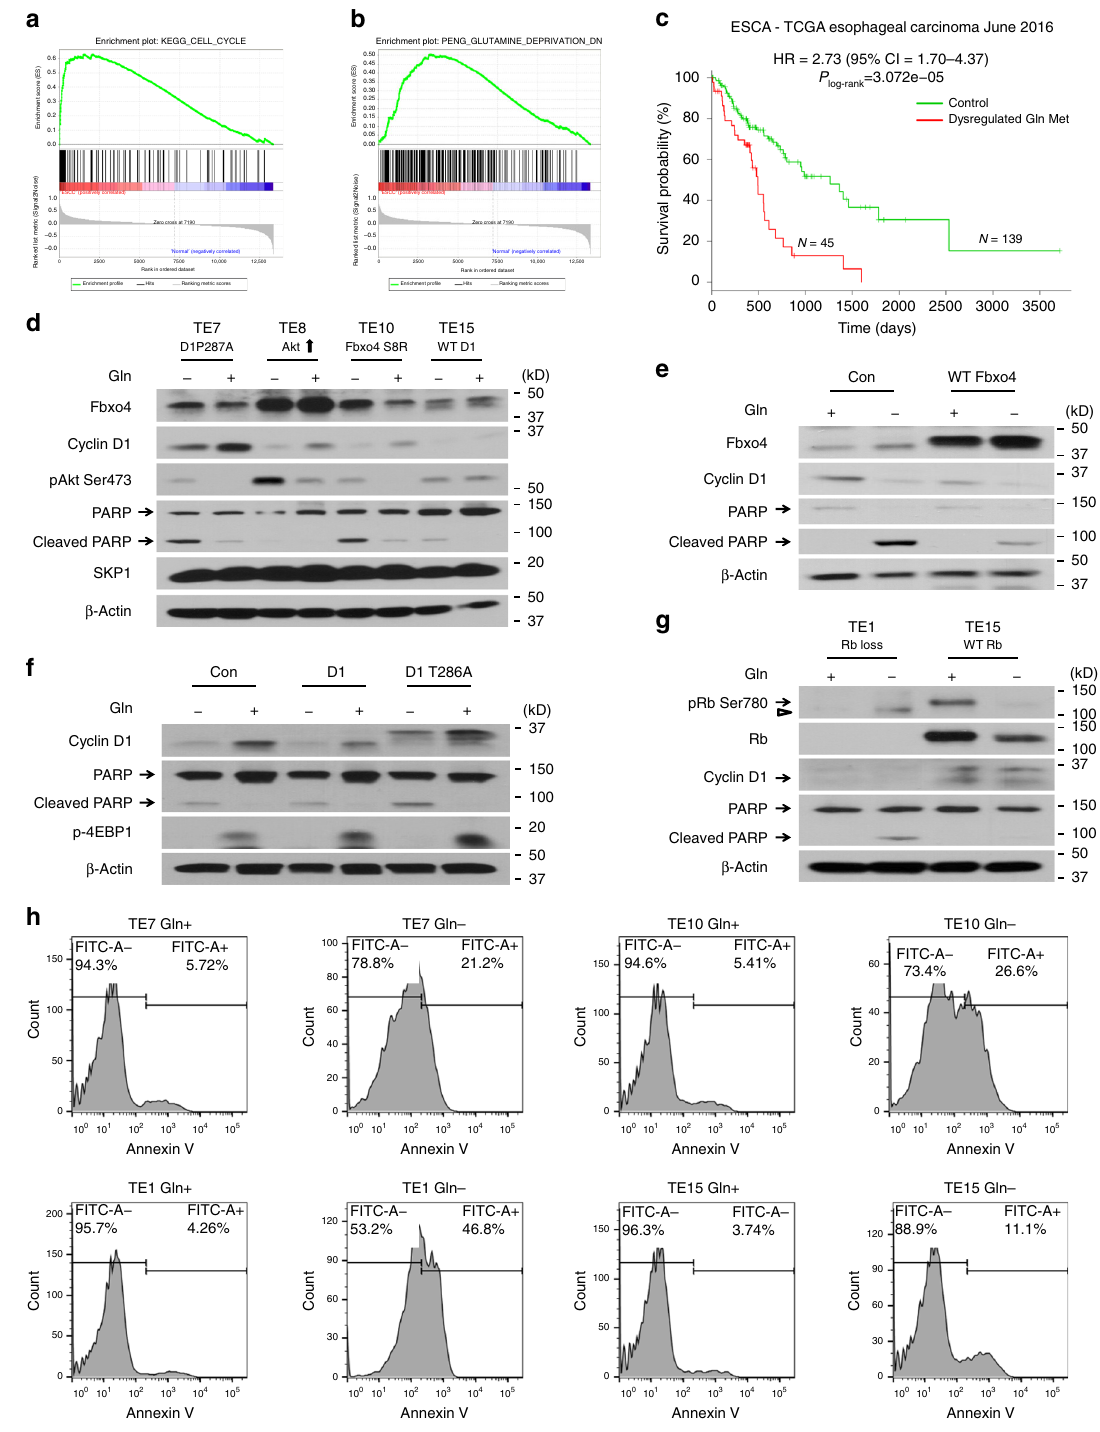
Fig. 2 Dysregulated Fbxo4-cyclin D1 axis promotes Gln-addiction in esophageal squamous cell carcinoma (ESCC) cells. a Gene set enrichment analysis (GSEA) enrichment of ESCC versus normal tissues for gene set “ Cell Cycle Regulation ” in NCBI GEO dataset (GSE100942): NES = 1.4644697, FDR q -val = 0.45459393. b GSEA enrichment of ESCC versus normal tissues for gene set related to “ Gln Metabolism ” in NCBI GEO dataset (GSE100942): NES = dysregulated Gln metabolism; HR: hazard ratio; CI: con fi dence interval. d Increased PARP cleavage following 24 h Gln-depletion in TE7 and TE10 versus TE15 cells. e WT Fbxo4 suppresses PARP cleavage following 24 h Gln-depletion in TE10 cells. f Overexpression of cyclin D1 or D1T286A promotes the sensitivity of TE15 cells to 24 h Gln-depletion. g Increased PARP cleavage in TE1 versus TE15 cells upon 24 h Gln-depletion. h FACS for Annexin V-positive cells with or without 48 h Gln-depletion in TE7, TE10, TE1, and TE15 cells. Arrow: band of interest; open triangle: non-speci fi c